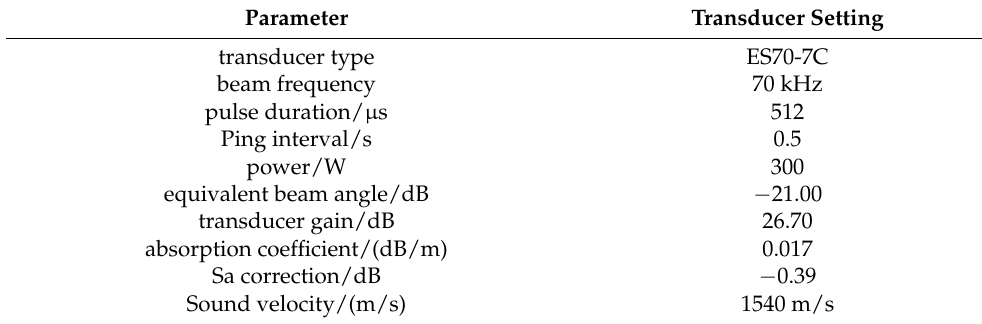
Table 1. Main settings of EY60